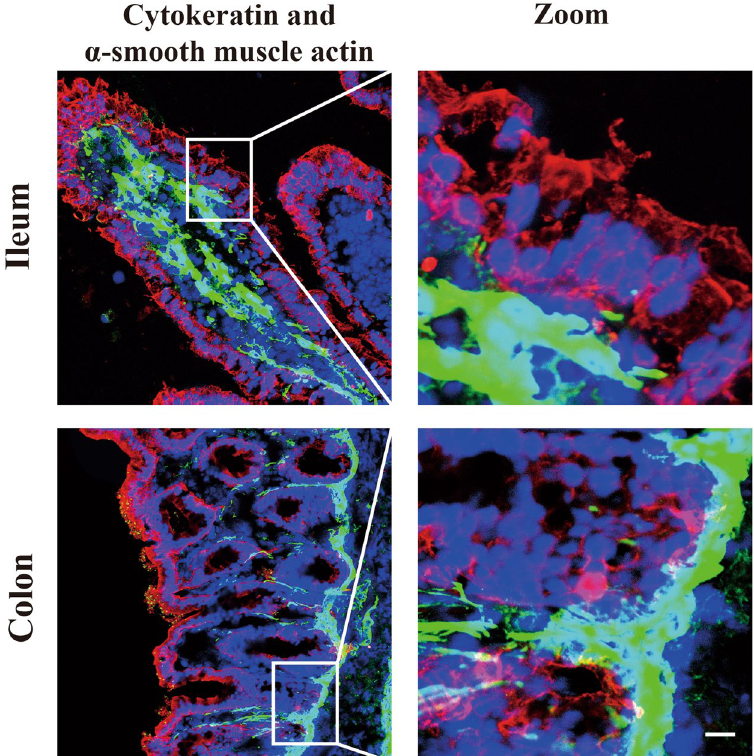
Figure 1. Characterization of the epithelial cells and myofibroblasts of the ileum and colon of a 3 days old piglet. Immunofluorescence staining against cytokeratin and α -smooth muscle actin in ileum and colon cryosections. A lot of myofibroblasts are located in the lamina propria underneath the epithelial layer of both tissues. Scale bar: 10 µ